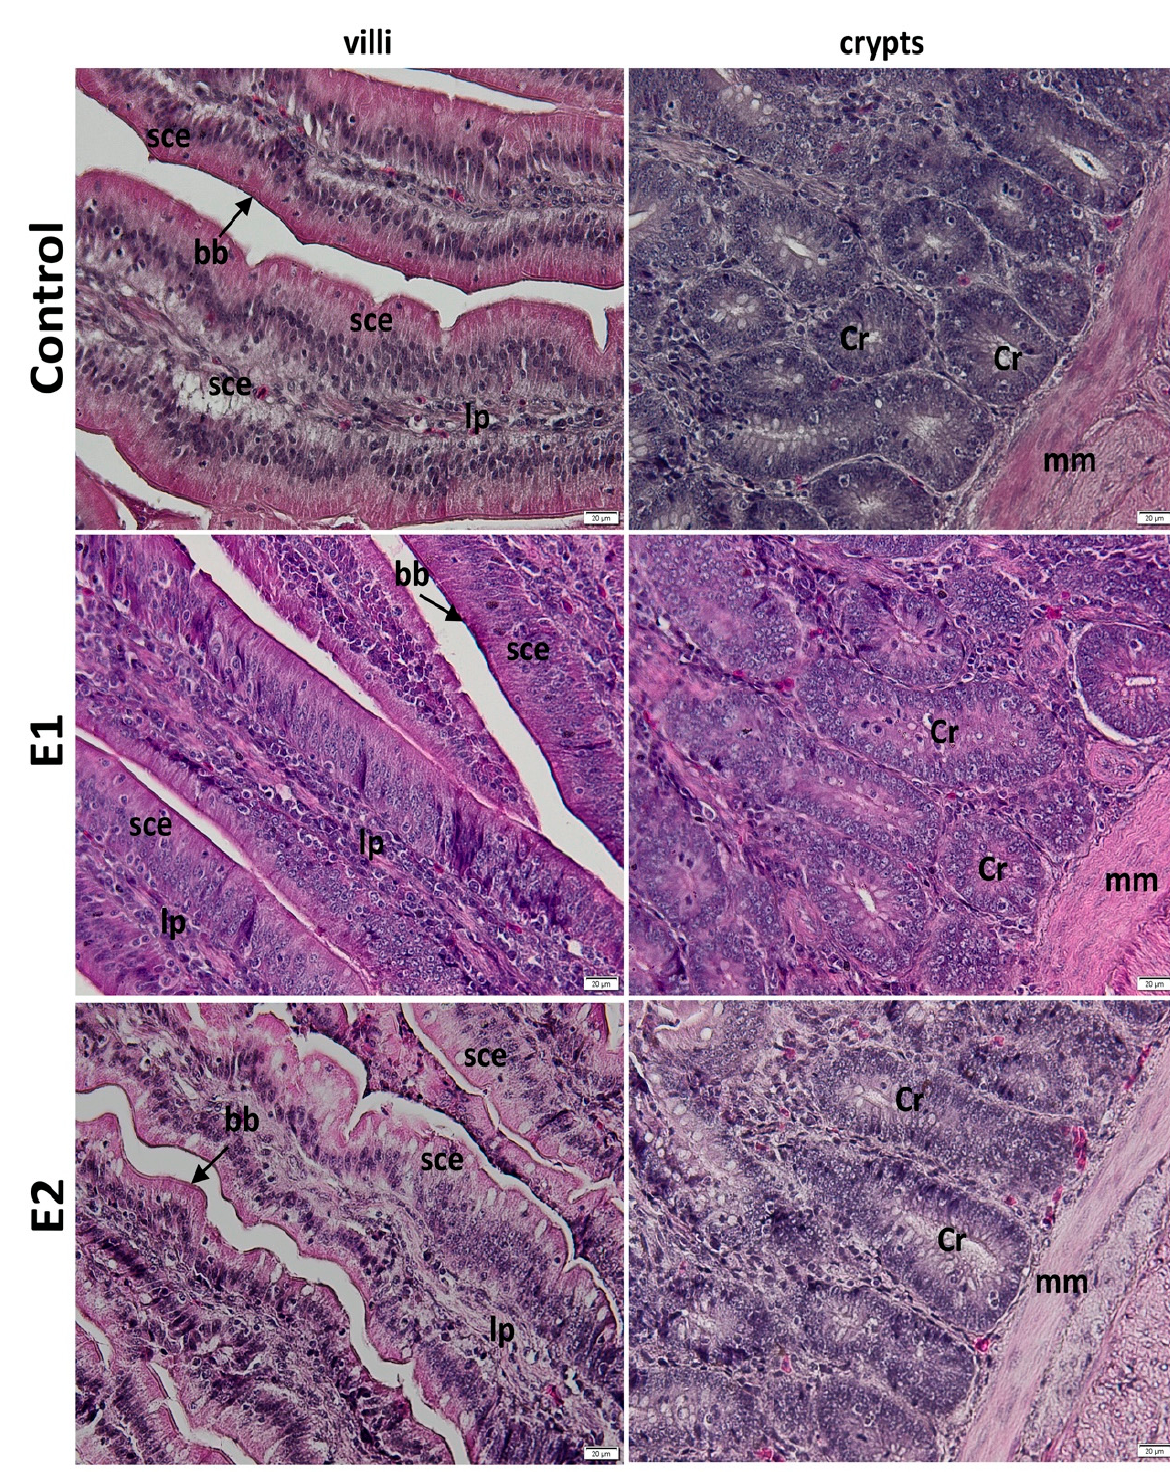
Figure 1. Effect of watermelon rind and sea buckthorn supplementation diet on the duodenum morphology of laying hens. The basal diet served as the control and the experimental groups were supplemented with watermelon rind (E1) and sea buckthorn (E2); sce, simple columnar epithelium; lp, lamina propria; cr, crypt; mm, muscularis mucosa. Bb, brush border; H&E (Hematoxylin and Eosin), Barr—20 μ m.